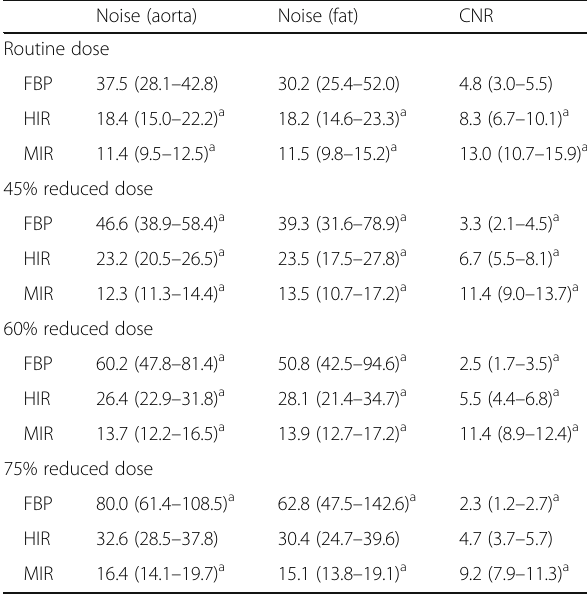
Table 2 Noise and CNR at different dose levels with FBP, HIR and